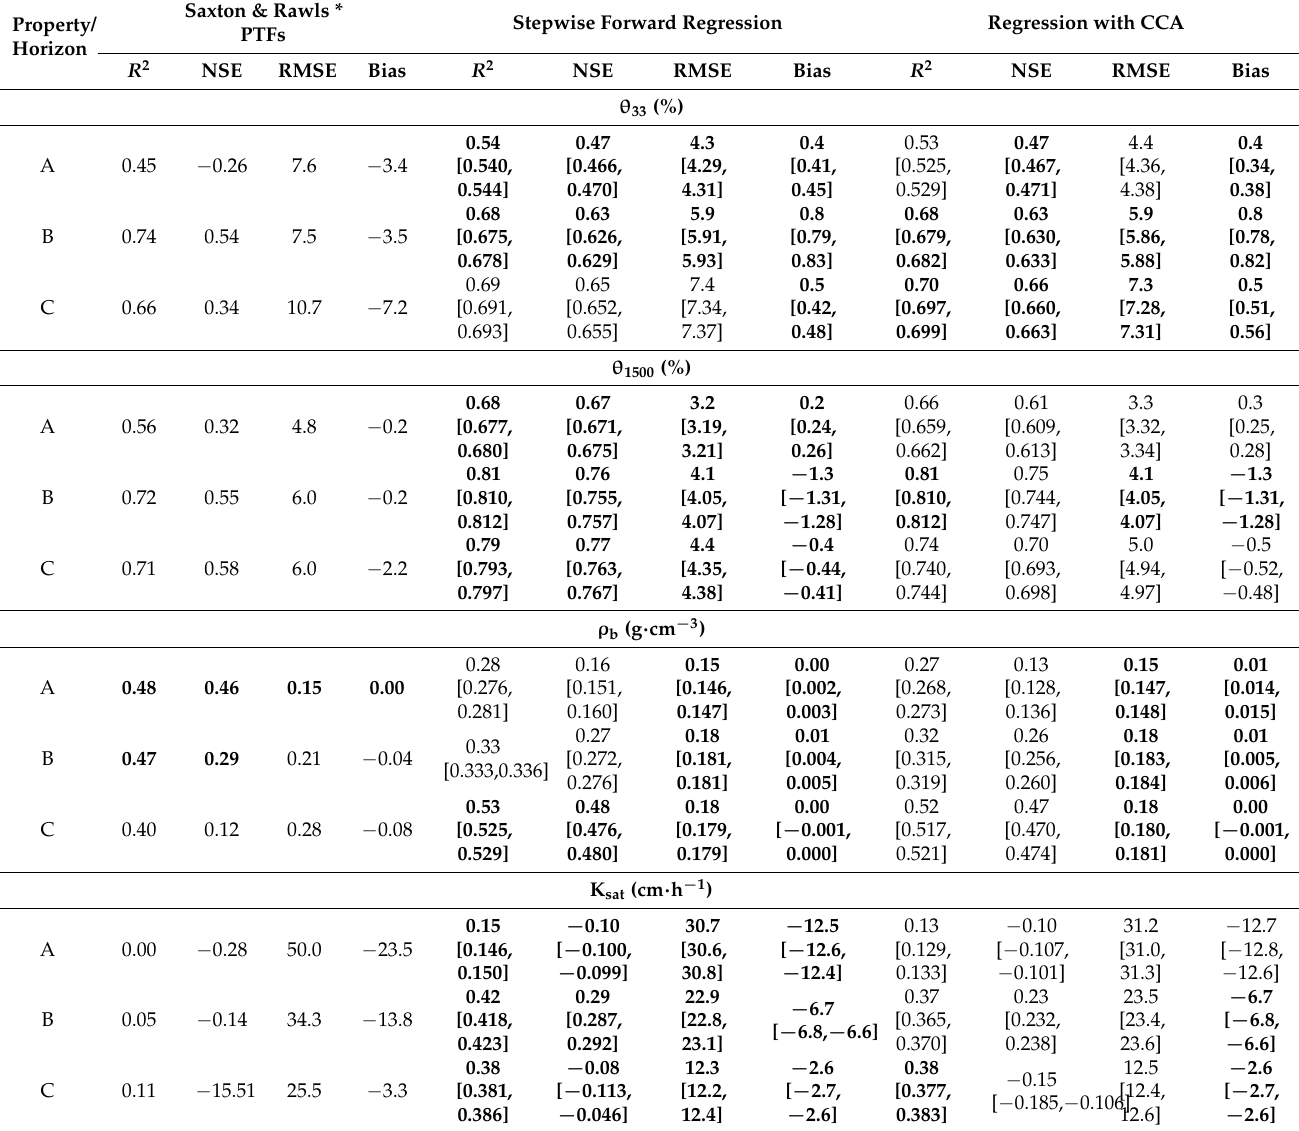
Table 8. Accuracy evaluation of existing and developed PTFs. Values in bold are the best perfor- mances. The values in square brackets are the maximum and minimum values calculated from the